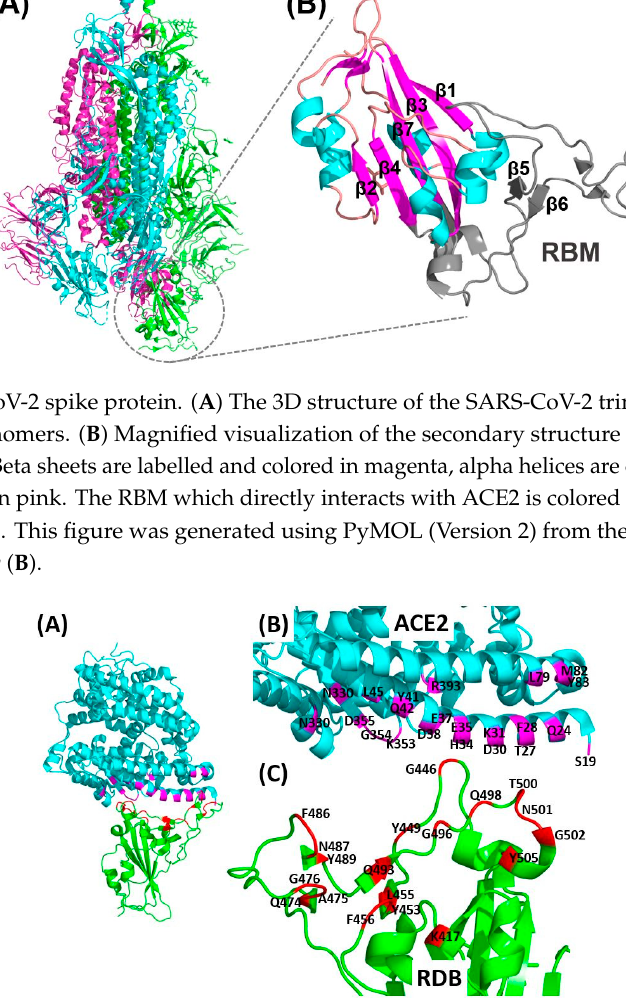
Figure 4. SARS CoV-2 spike RBD − ACE2 binding interface. ( A ) The resolved 3D crystal structure of the SARS CoV-2 spike RBD in contact with human ACE2 receptor (PDB: 6LZG). The ACE2 is colored in cyan and its interacting amino acids are colored in magenta while the RBD is colored in green and its interacting amino acids are colored in red. ( B ) Zoom-in (or enlarged) view of the ACE2 showing the residues that are involved in hydrogen binding with the RBD. ( C ) Zoom-in view of the RBD showing the residues that are involved in hydrogen binding with ACE2. The labelled amino acids of ACE2 and RBD in ( B , C ) refer to all the interacting residues that are reported in the four resolved RBD − ACE2 structures (PDBs 6VW1, 6M0J, 6M17 and 6LZG); PDB 6LZG was used as a representative only. Refer to Table 1 for the detailed description of hydrogen bonds formed by the highlighted residues. This figure was generated using PyMOL (Version 2).